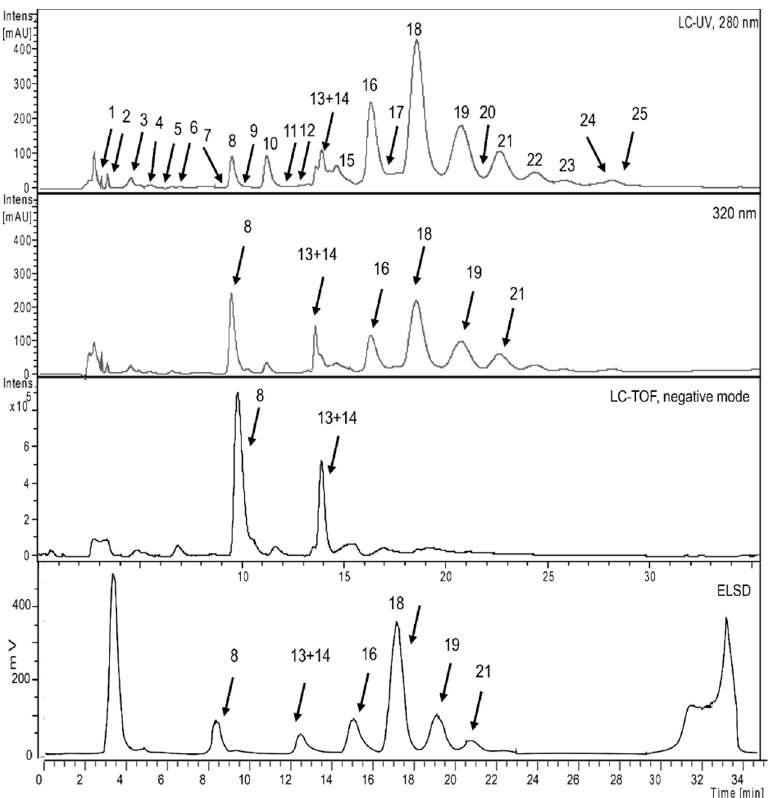
Figure 1. Phytochemical analysis of an EtOAc extract of P. persica performed using HPLC-TOF-MS combined with UV (280, 320 nm) and ELSD detection.